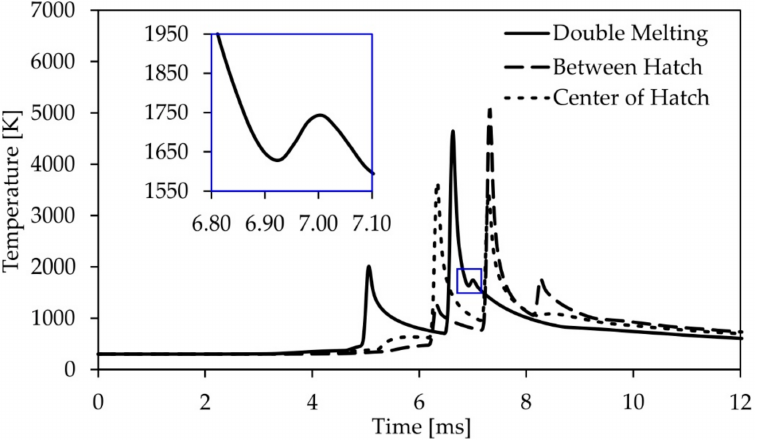
Figure 4. Thermal history of additively manufactured stainless steel 316L generated using the laser powder bed fusion process model developed by Wolfer et al. at a location between the hatch lines, in the center a hatch line, and at a location that undergoes rapid double melting. The inset figure is taken from the area marked by the blue square to highlight the rapid double melting seen at various locations in the